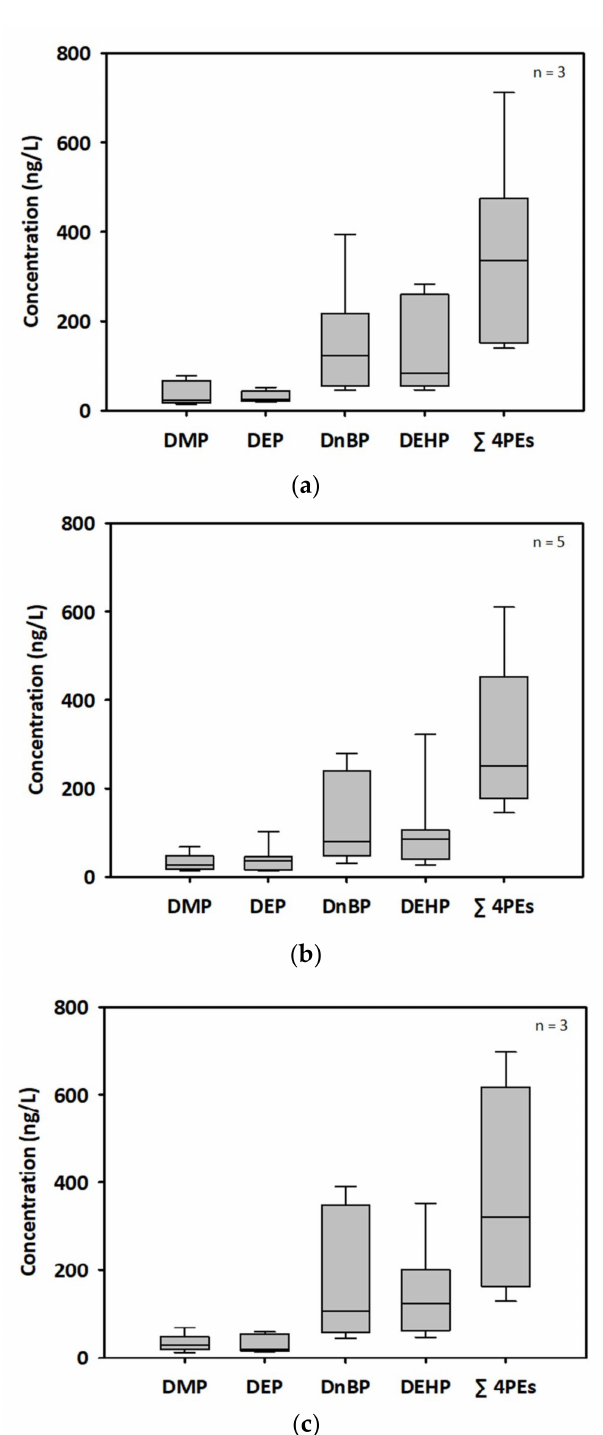
Figure 6. The occurrence of four phthalate esters (PEs) at three sites: ( a ) the northern end, ( b ) the middle, and ( c ) the southern end of Ilsan Beach, South Korea, during Winter and Spring of 2018. n = number of sampling; DMP—dimethyl phthalate; DEP—diethyl-phthalate; DnBP—di- n -butyl-phthalate; (cid:80) DEHP—bis(2-ethylhexyl)-phthalate; 4 PEs—sum of the four PE concentrations. The error bars indicate the standard